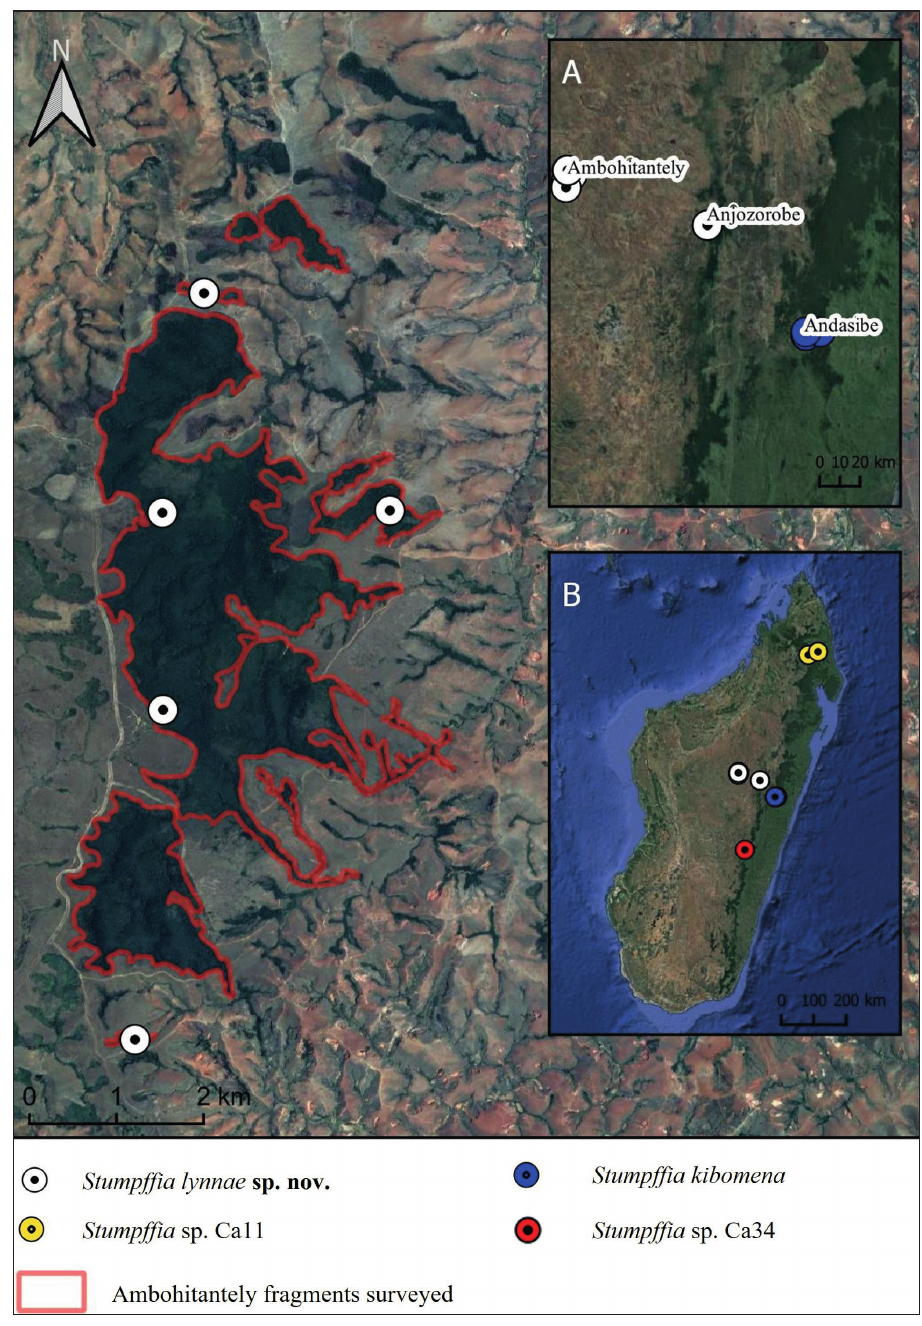
Figure 1. Map of Ambohitantely Special Reserve showing known Stumpffia lynnae sp. nov. distribution. A Ambohitantely, Anjozorobe, and Andasibe relative to one another B map of Madagascar showing the wider distribution of Stumpffia lynnae sp. nov. and its sister species Stumpffia kibomena , Stumpffia sp. Ca11 and Stumpffia sp. Ca34. Satellite imagery Google Earth